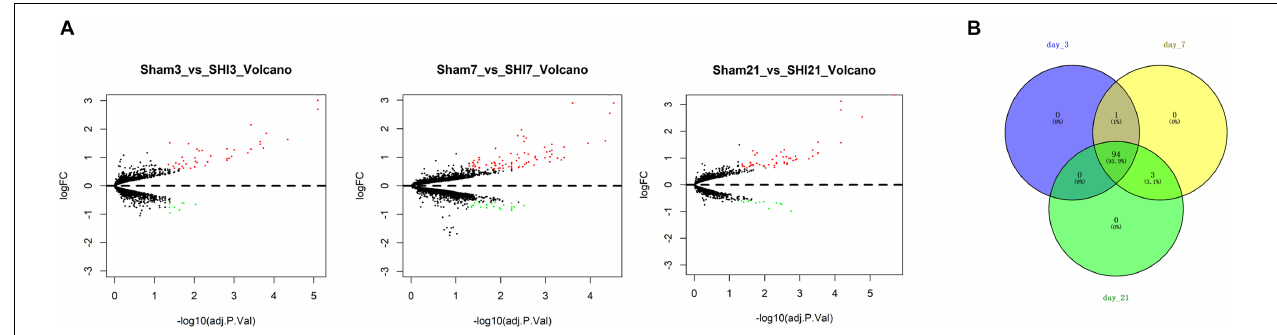
FIGURE 1 | Identification of NP-associated genes. (A) Volcano Plots of the DEGs in the SNI group versus the Sham group at 3, 7, and 21 days after surgery, respectively; (B) Venn diagram showed the common NP-associated genes from the 3 time periods.